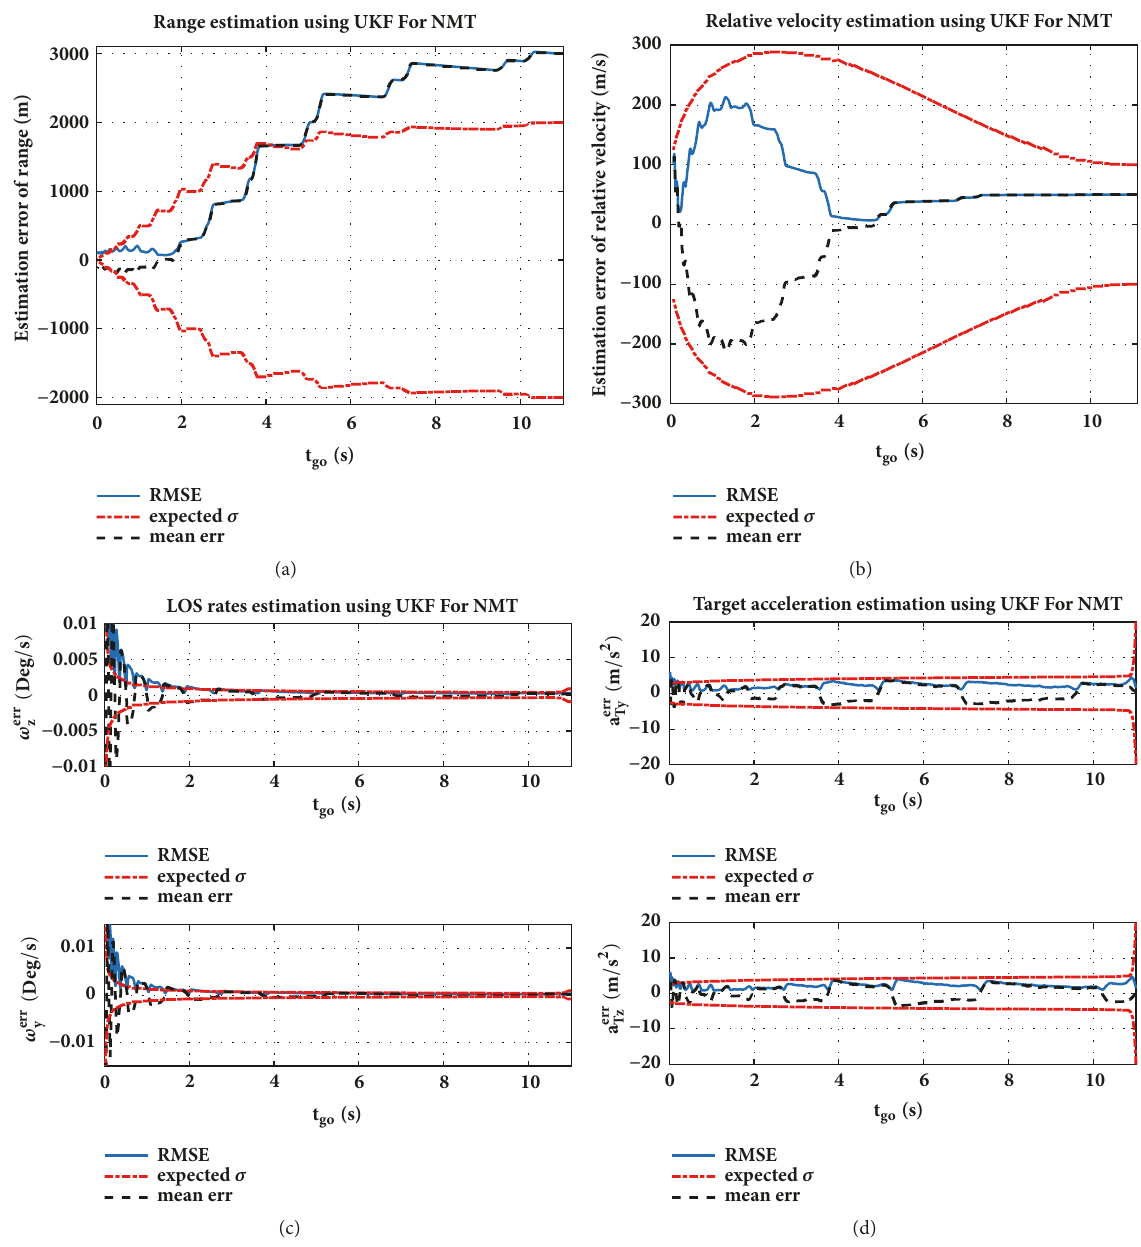
Figure 7: (a) Range estimation errors using UKF for NMT. (b) Relative velocity estimation errors using UKF for NMT. (c) LOS rates estimation errors using UKF for NMT. (d) Target acceleration estimation errors using UKF for